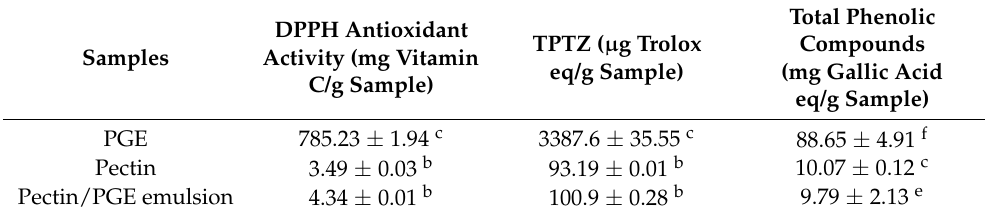
Table 4. Total phenolics and antioxidant activity profile of PGE, Pectin, and Pectin/PEG emulsion.